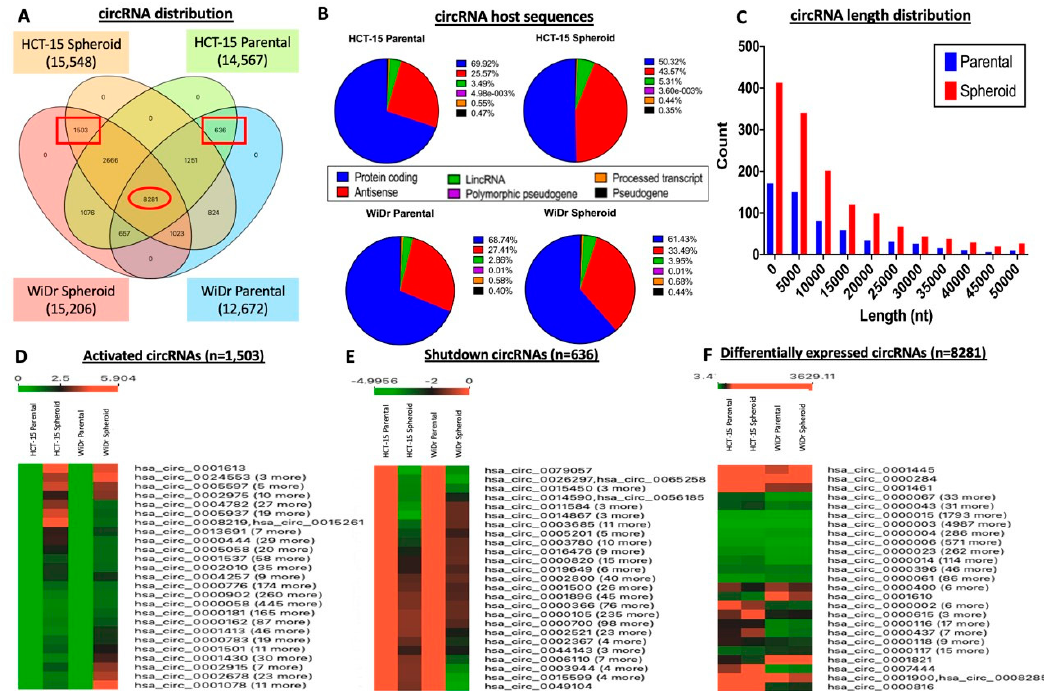
Figure 3. Genome-wide expression profiling of circRNAs in the CRC spheroid CSC cells. ( A ) Overlapping circRNAs identified in the CRC and spheroid CSC cells. The numbers in red boxes indicate circRNAs that were either activated or up-regulated (left red box), or shutdown or down- regulated (right red box), and the red oval box indicates circRNAs that were differentially expressed in the spheroids relative to the parental CRC cells. ( B , C ) Distribution of the sources of the host transcripts ( B ) and length distribution ( C ) of the differentially expressed circular RNAs. The results shown are combined data of the two cell lines. nt, nucleotide. ( D – F ) Hierarchical clustering analysis of activated ( D ) and shutdown ( E ) circRNAs, in terms of activation and shutdown from and to zero expression level, respectively (see also square boxes in Figure 3A), and differentially expressed circRNAs (F; see also the oval box in Figure 3A) in the spheroids relative to the CRC cells. Apart from a representative circRNA shown in its designation in an expression-level cluster, the total number (n) of circRNAs in each expression cluster is also shown in brackets.